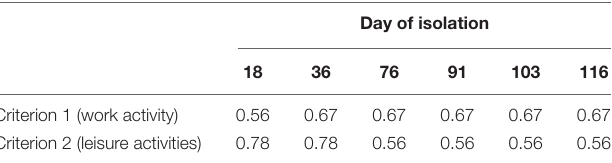
TABLE 4 | Crew cohesion criteria during the 4-month